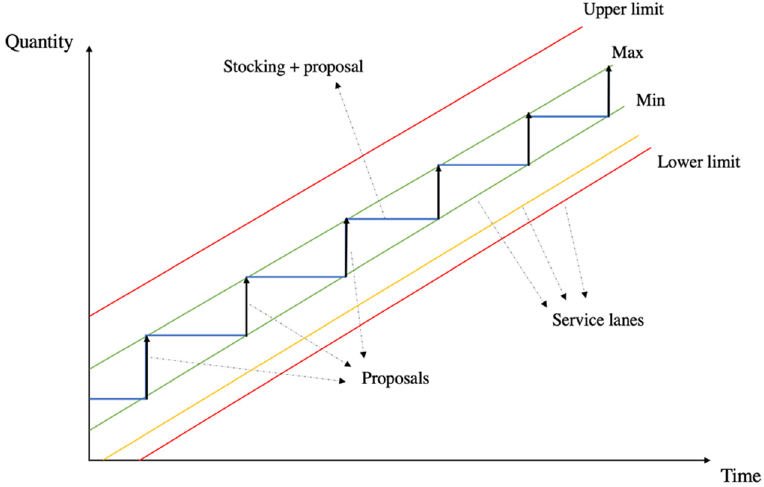
Figure 2. The Service Lane Planning concept–Note Adapted from Bernocco et al. (2003) .